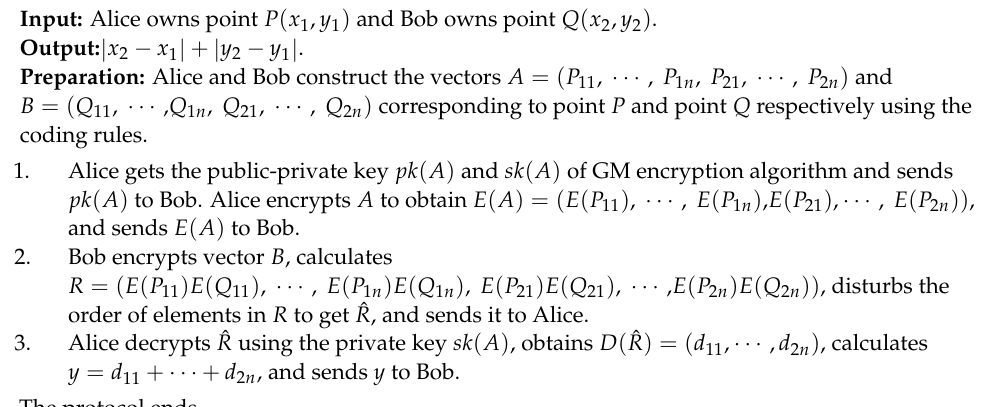
Algorithm 1 Securely computing the Manhattan distance under the semi-honest model